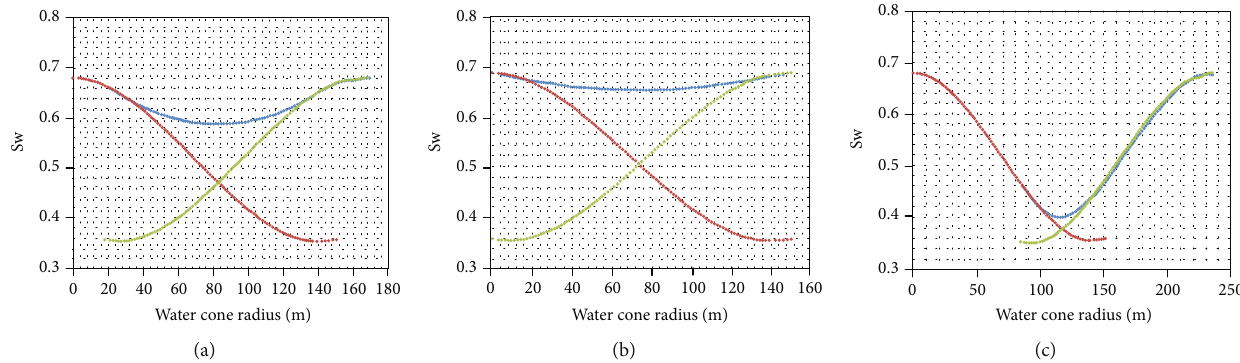
Figure 9: In fl uence of an adjacent well on the water cone